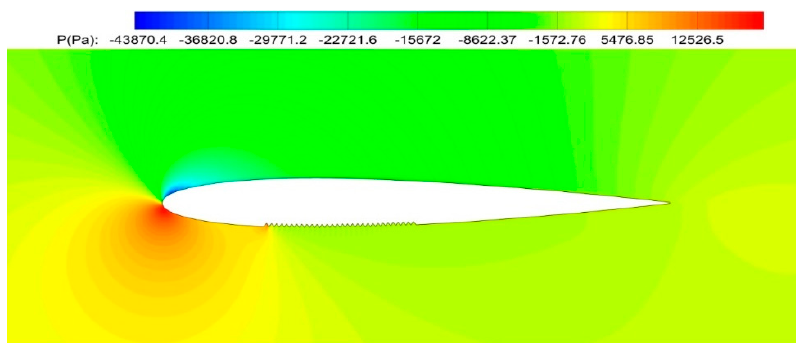
Figure 18. 4° angle of attack, streamline of grooves on the suction side. Figure 19. 4° angle of attack, streamline of standard NACA0012 airfoil. Figure 20. 4° angle of attack, streamline of grooves on the pressure side. Figures 21–23 are the calculations of the three airfoils at their respective stall angles of attack. It can be found that, compared with the standard airfoil, the stall angle of attack of the airfoil with grooves on the suction side is significantly increased to 19°, while that of the airfoil with grooves on